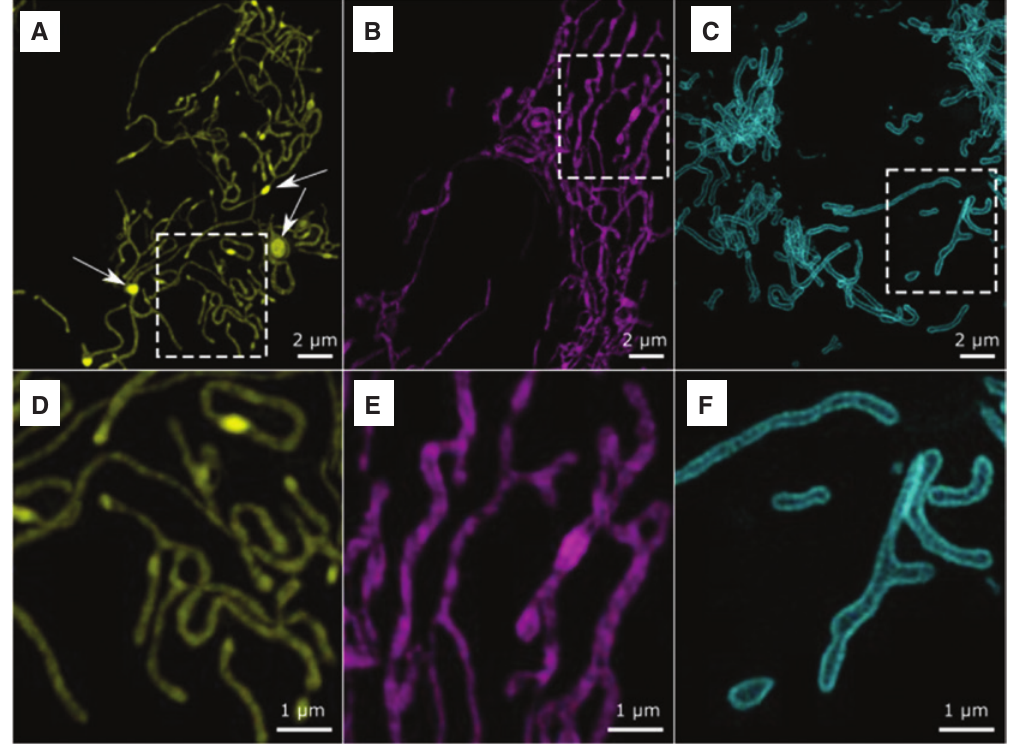
Figure 1: Live imaging of MCC13 cells individually labeled with three mitochondrial probes. (A) CellLight Mitochondria-RFP BacMam 2.0 (BM) localizes in the mitochondrial matrix. Larger aggregates (indicated by arrows in A) are thought to be labeling artifacts. (B) MitoTracker Deep Red (MT) accumulates in the intermembrane space, and gaps correspond to the pres- ence of cristae. (C) mEmerald-TOMM20 (Gtom) appears along the outer mitochondrial membrane. Panels (D–F) provide a closer look at the boxed regions in A–C. Images are maximum intensity projections of 3D SIM